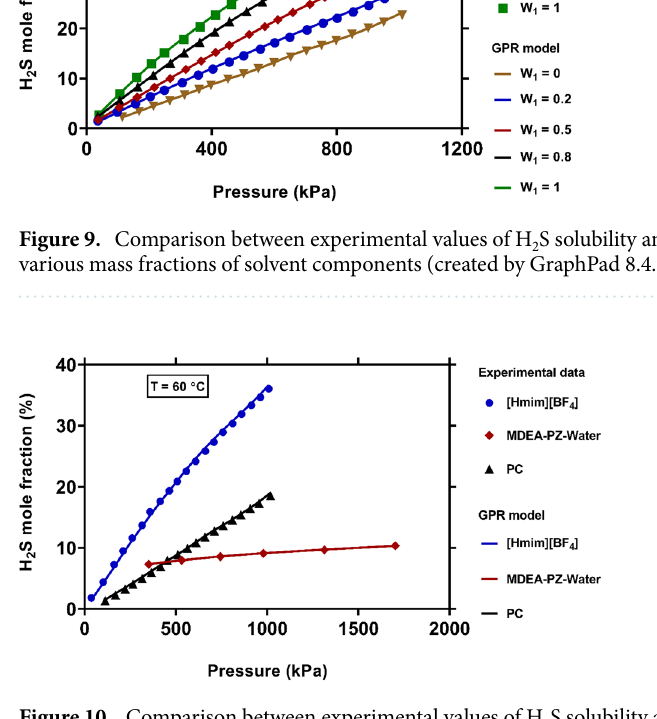
Figure 10. Comparison between experimental values of H 2 S solubility and those predicted by the novel model when using various types of solvents (created by GraphPad 8.4.3.686 145